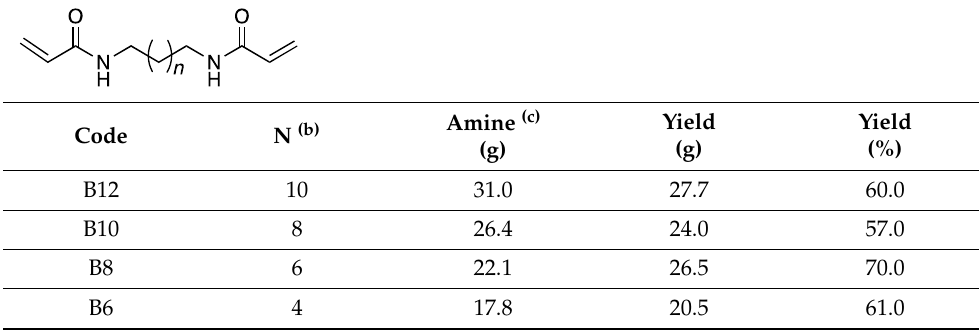
Table 1. Amounts of reagents used in the synthesis of bis-acrylamides (a) .